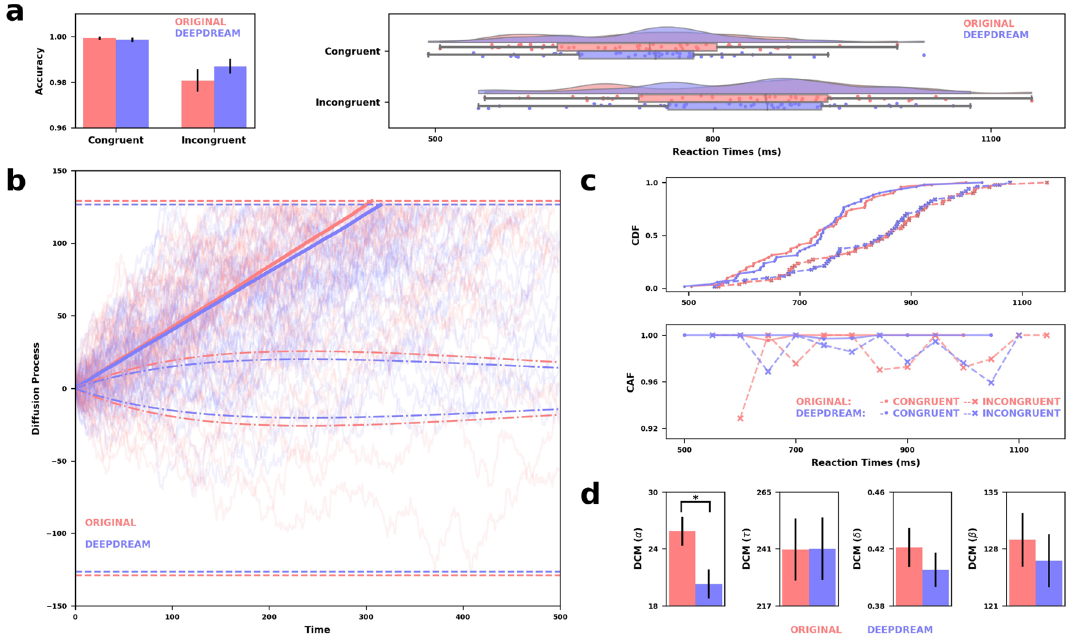
Figure 4. ( a ) On the left, bar plots of the accuracies between OR (red) and DD (blue) conditions, and congruent and incongruent trials, with error bars indicating SEM and horizontal bars representing statistical significance. On the right, raincloud plots of the RT across Stroop conditions. ( b ) Graphical depiction of the results from the DCM. Semi-transparent solid lines are 10,000 trials simulated per condition using recovered parameters from model fitting. Solid lines are the average of the simulated trials per condition. Dash-dotted lines represent the automatic process, while dashed lines represent boundaries. ( c ) Group-level statistics were used for fitting the DCM. On the top, the cumulative distribution functions (CDF), while on the bottom are the conditional accuracy functions (CAF), both plotted across Stroop conditions. ( d ) Barplots indicating the estimated parameters from DCM [ α = amplitude of the automatic process, τ = decay of the automatic process, δ = drift of the controlled process, β = decision boundary]. Error bars indicating SEM and horizontal bars representing statistical